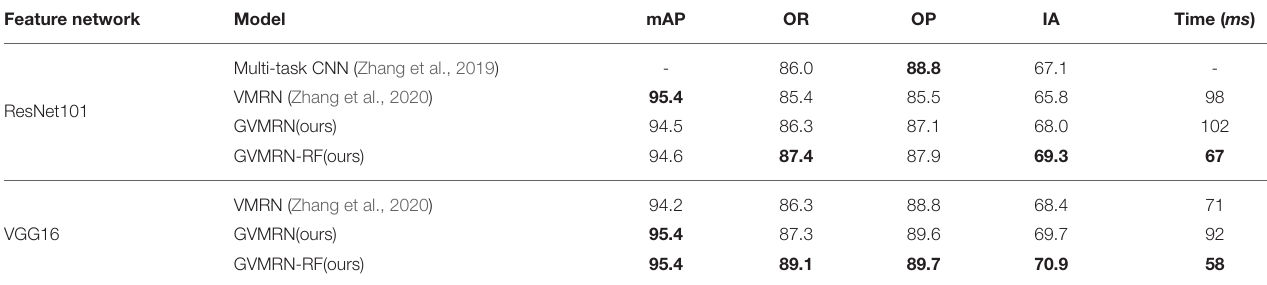
TABLE 1 | Results of visual manipulation relationship reasoning. Feature network